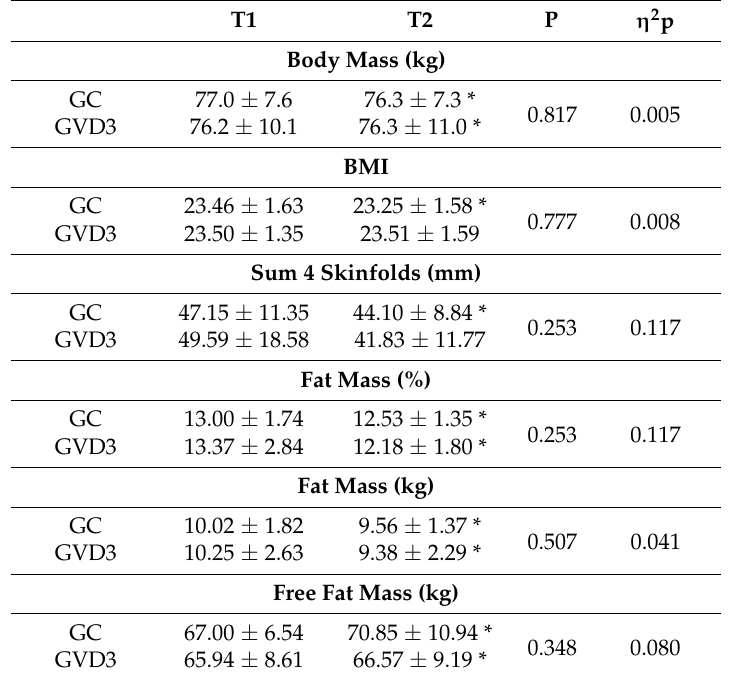
Table 6. Body composition in the control group (CG) and vitamin D3 group (VD3G) at baseline (T1) and after 8 weeks